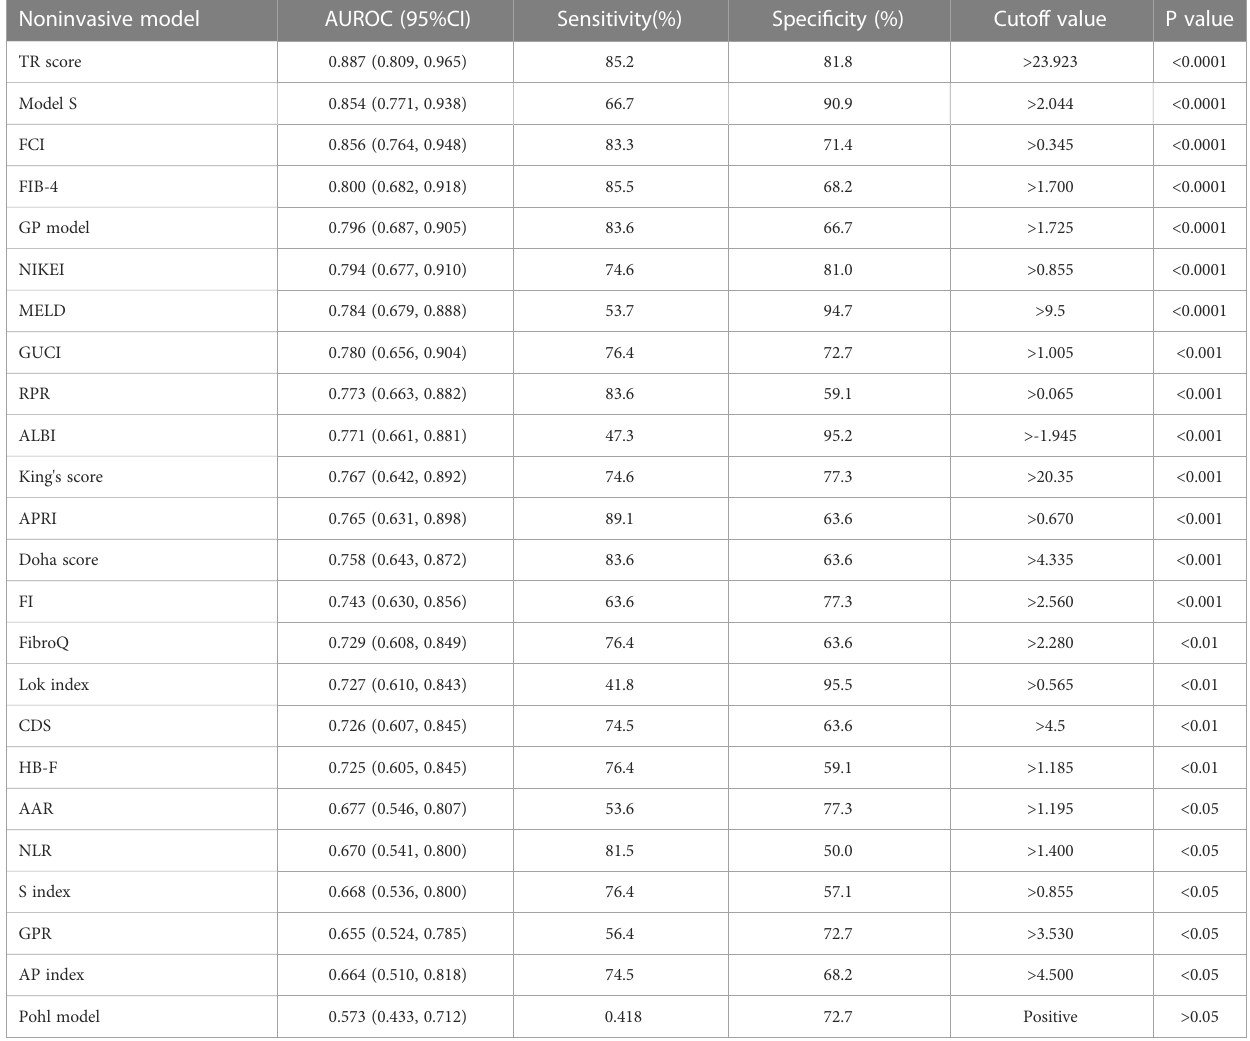
TABLE 5 Validity of each models for prediction of